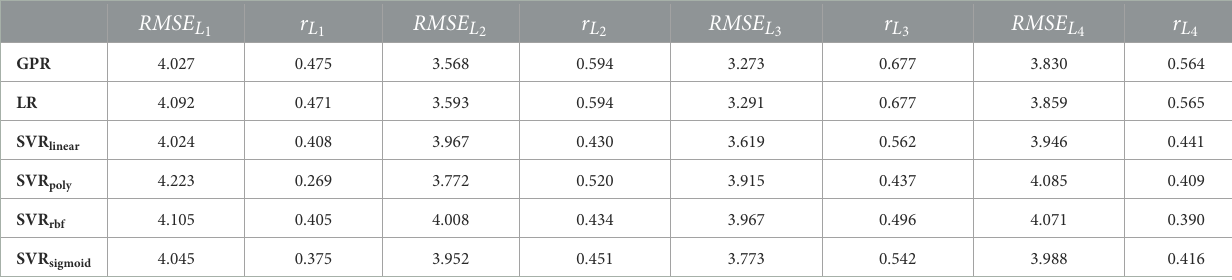
TABLE 2 Criterion validity of frequency-domain feature modeling using different numbers of wavelet decomposition layers.